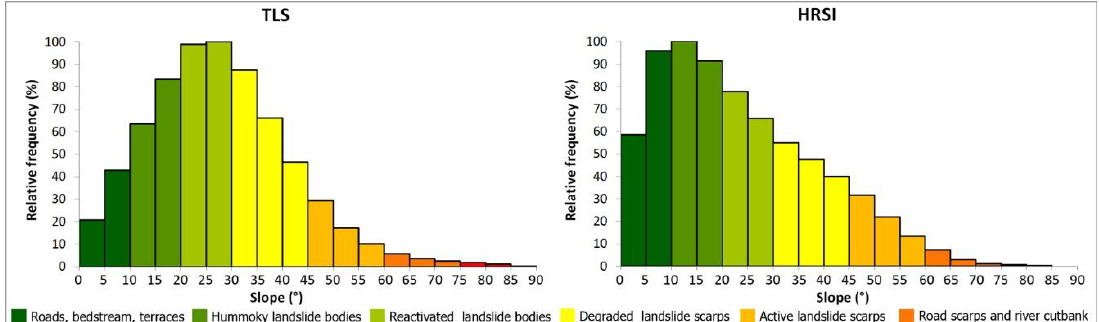
Figure 8. Percentage frequency histograms of slope values.